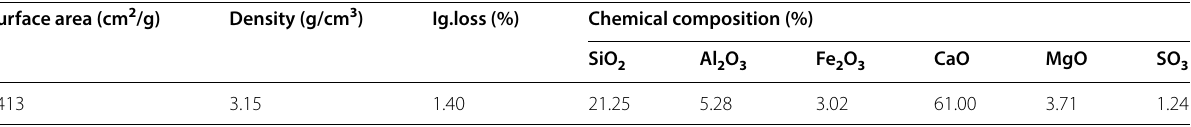
Table 2 Chemical compositions and physical properties of cement. Surface area (cm 2 /g)